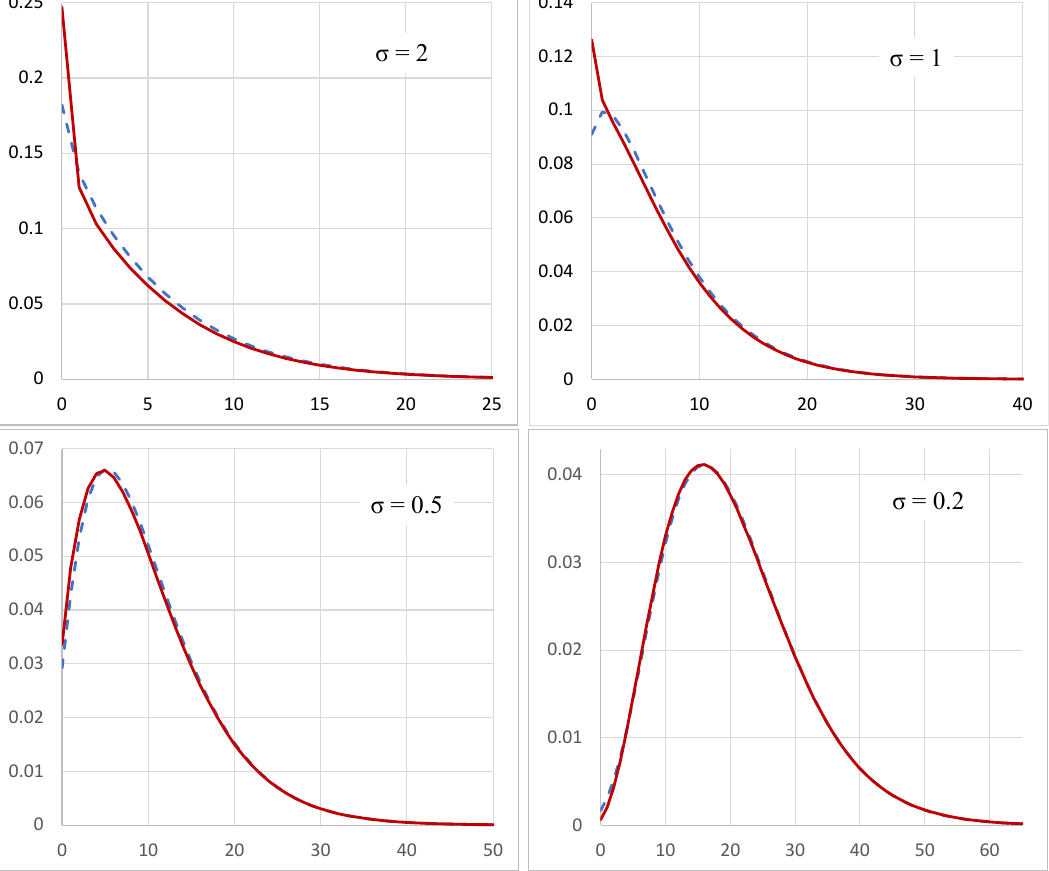
Figure 2. Comparisons of the approximation (dashed line) and the simulation results (solid line) obtained for the probability distribution of the number of customers in the orbit for ρ = 0.8 and various values of σ